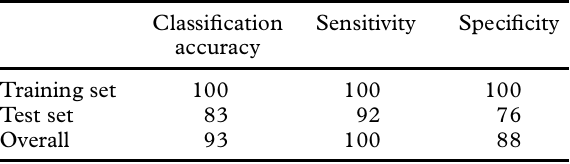
Table 3. Results a of the SCS-based classi(cid:142) cation of 1 H MR spectra in the diagnosis of soft tissue